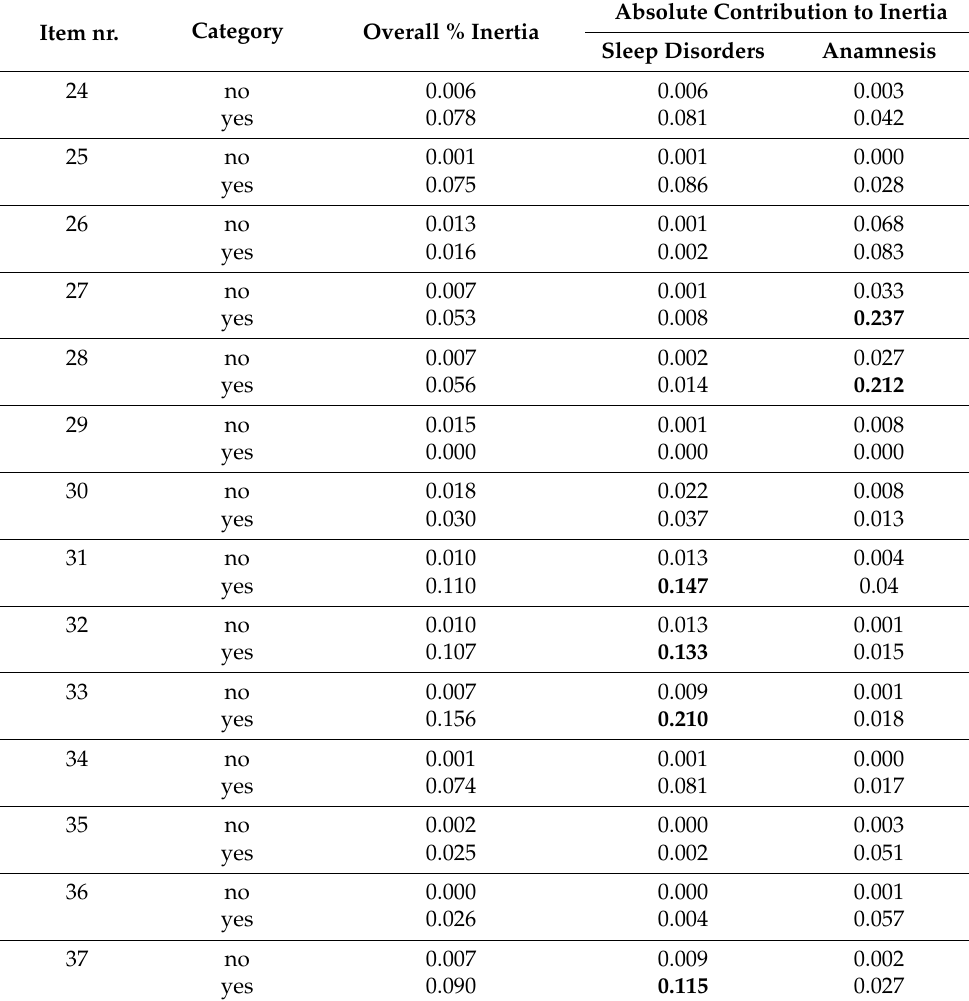
Table 3. Multiple correspondence analysis (MCA) results of the additional 15 items for OSAS: overall percentage of inertia and absolute contributions of categories to each